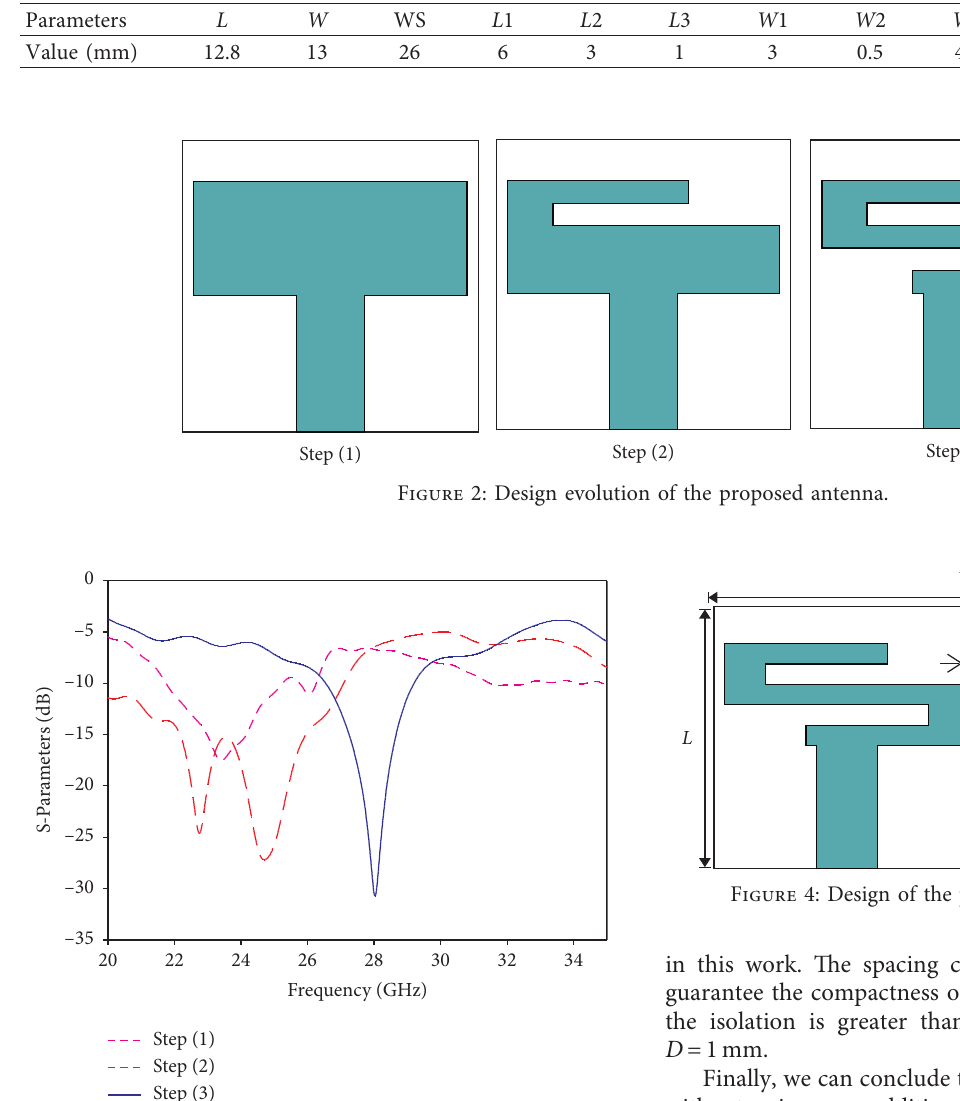
Figure 3: Return loss of three antennas configurations.